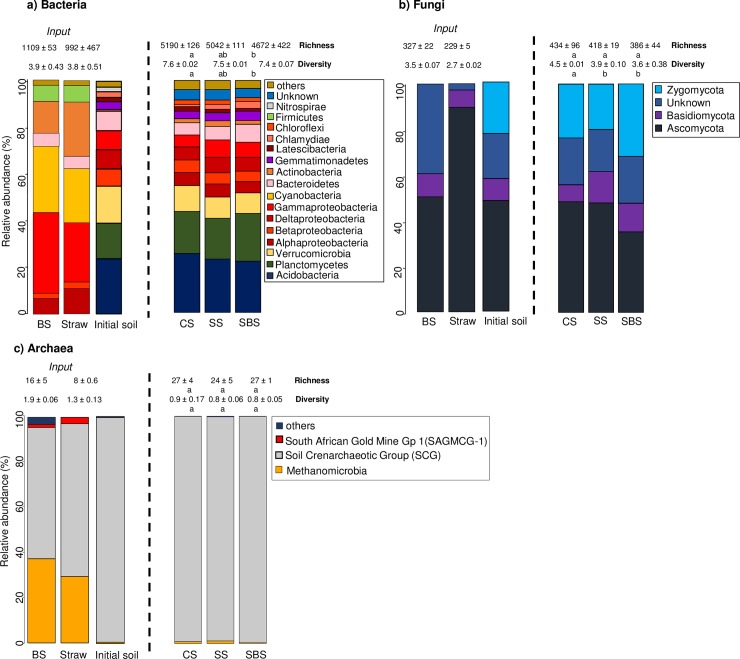
Composition of the bacterial (a), fungal (b) and archaeal (c) microbial community in the various samples. Pristine microbial composition of the BS and straw (“Input”) and composition of the bacterial, fungal and archaeal communities at the phylum level (and class level for the Proteobacteria and archaea) in the three soil treatments after 7 weeks (49 days) of incubation with the associated richness and Shannon diversity index. BS: biostimulant samples, CS: control soil, SS: soil with straw, SBS: soil with straw and BS, Means and standard errors were calculated (n = 3). The Kruskal-Wallis test was performed (P<0.05). Different letters correspond to significantly different values.